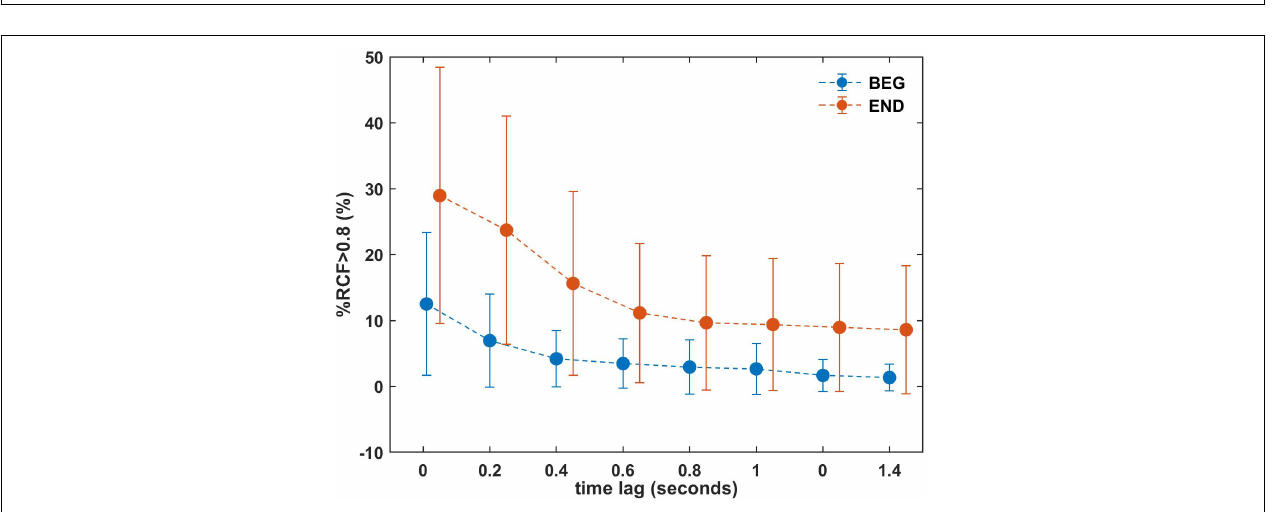
FIGURE 6 | Mean of %Range (END – BEG) determined for the analyzed windows ( W ). Each point represents the value of the percentages characterizing the deviations in the END segment in relation to BEG. Error bars represent the standard deviation.